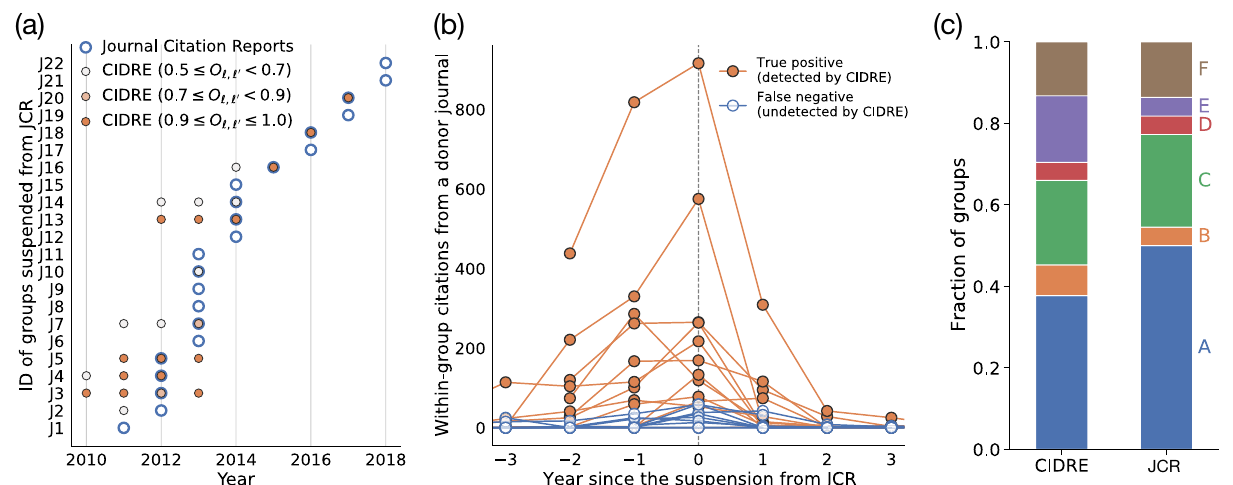
Figure 2. Overlap between journal groups identified by JCR and CIDRE. ( a ) Years when the journal groups are identified. The circles with thick borders represent the groups suspended from JCR. The filled circles represent those detected by CIDRE. The hue of the circles indicates the value of the overlap, O ℓ , ℓ ′ , i.e., the fraction of journals in group ℓ ′ detected by CIDRE that belong to group ℓ suspended from JCR. CIDRE detected 11 out of the 22 groups suspended from JCR in the year of the suspension or before. ( b ) Number of within-group citations per year from a donor journal excluding self-citations. If the group has multiple donor journals, we show the count for the donor journal that provides the largest number of within-group citations. The horizontal axis indicates the year relative to that in which the journal group is suspended from JCR. Therefore, a negative value indicates a year before JCR suspended the journal group. For groups J17, J19, and J22, the donor journals do not provide any within-group citations for the 3 years before the suspension. ( c ) Classification of journal groups identified by CIDRE and